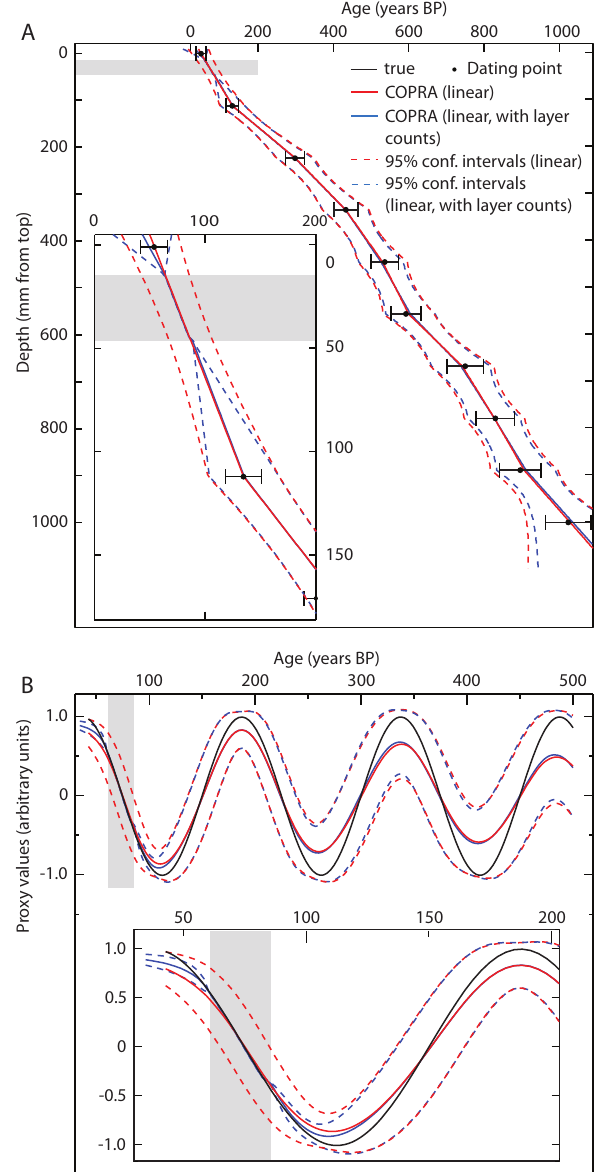
Fig. 6. Illustration of layer counting effects using synthetic data: (A) median age model for the synthetic dataset (linear interpolation, with/without layer counted information, which is available in the grey shaded region) shown along with the “true” depth-age curve. Inset : detailed view highlighting the improvement of confidence bounds inside the layer counted interval. (B) Median proxy record estimated for the age models in (A) . Inset : detailed view showing better constrained proxy estimates after inclusion of layer counted data, compared to result not considering layer counts. 95% confi- dence bounds were constructed using ± 2-standard deviations from the median (legend valid for A and B